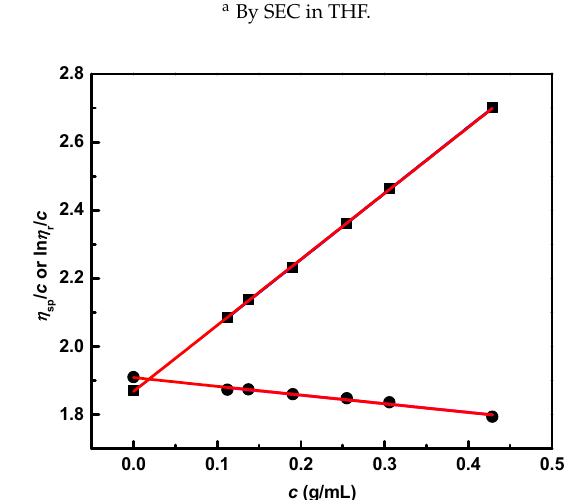
Figure 7. Viscometry results of sample 2 (Table 4) in THF at 35 °C.